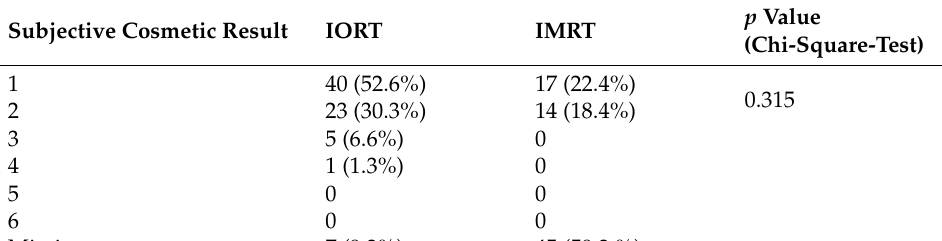
Table 4. Subjective cosmetic result evaluated during radiotherapy series, scale equal to school grades (1: very good, 6: poor).